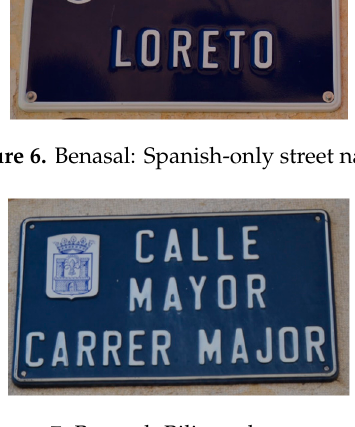
Figure 7. Benasal: Bilingual street name .